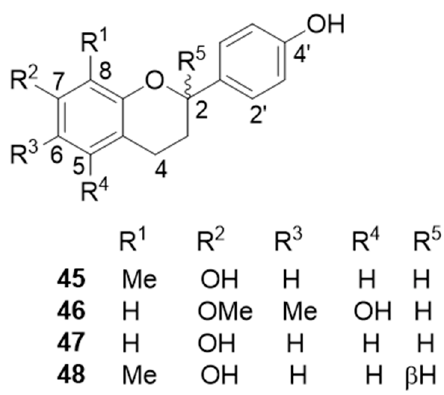
Figure 10. Selected flavans from D. cochinchinensis red resin.